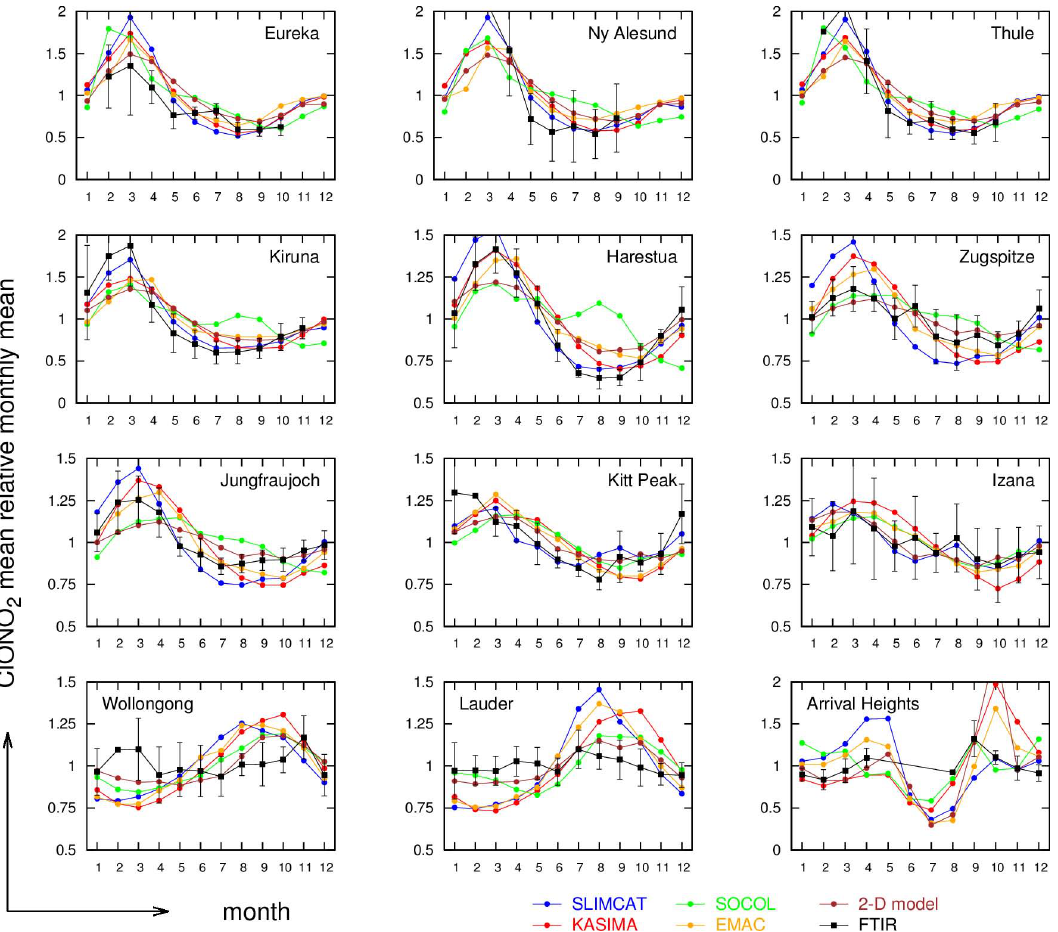
Fig. 7. Annual cycle of ClONO 2 at the different sites as determined from the FTIR instruments (black) and simulated by SLIMCAT (blue), KASIMA (red), SOCOL (green), EMAC (orange), and the Bremen 2-D model (brown). The mean relative monthly means were calculated by normalising the monthly means with the respective annual mean and then averaging over the period 2000–2009. The error bars of the FTIR measurements represent the standard